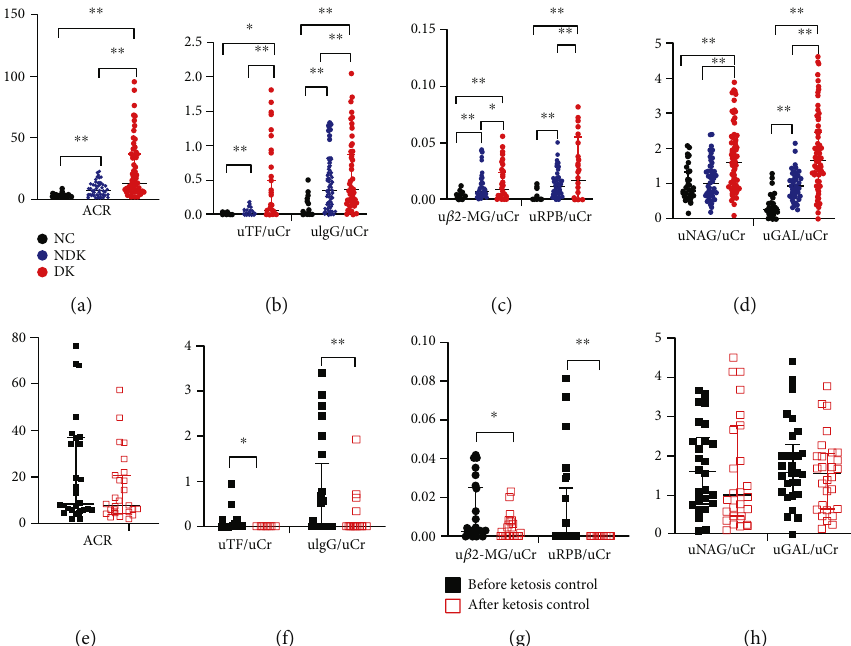
Figure 1: Glomerular and tubular injury in NC, NDK, and DK patients. Quantitative analysis of ACR (a), uTF/uCr and uIgG/uCr (b), u β 2- MG/uCr and uRBP/uCr (c), uNAG/uCr and uGAL /uCr (d) in three groups , ACR (e), uTF/uCr and uIgG/uCr (f), u β 2-MG/uCr and uRBP/ uCr (g)and uNAG/uCr and uGAL /uCr (h) after control of diabetic ketosis. ACR, albumin creatinine ratio;u β 2-MG, urine β 2- microglobulin; uGAL, urine β -galactosidase; uIgG, urine Immunoglobulin G; uNAG, urine N-acetyl- β -glucosaminidase; uRBP, urine retinol-binding protein; uTF, urine Transferrin; uCr, urinary creatinine; NC, normal control; NDK, non-diabetic ketosis; DK, diabetic ketosis. ∗∗ Represents P < 0 : 01 ; ∗ represents P < 0 : 05